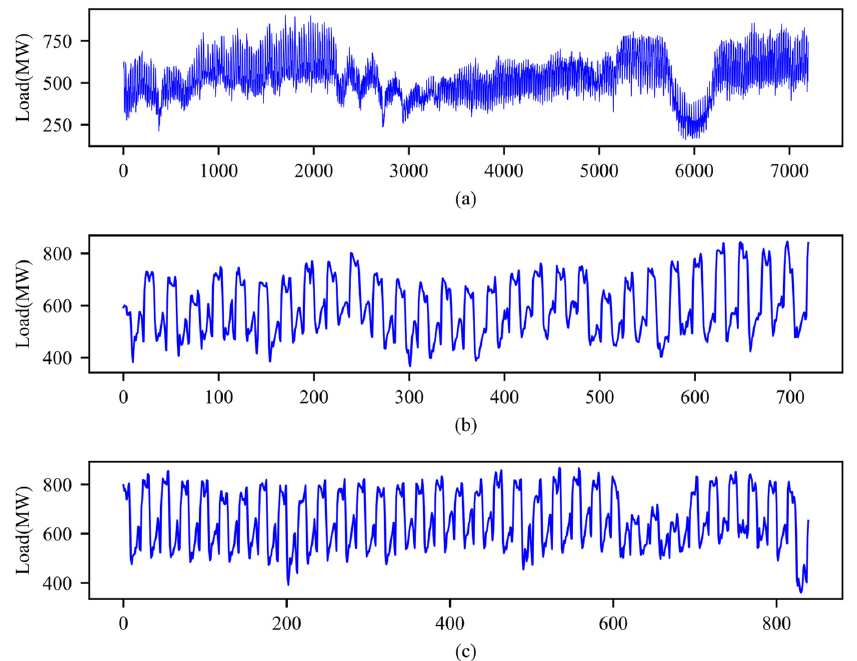
Figure 6. Training, validation and testing datasets used in this paper: ( a ) training dataset, ( b ) validation dataset, ( c ) testing dataset.